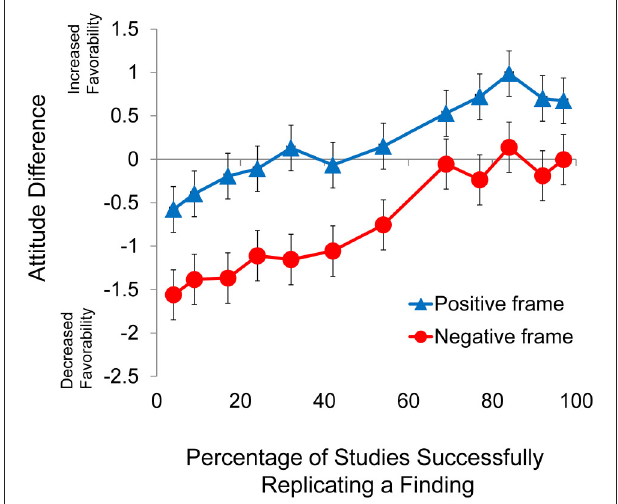
FIGURE 1 | Difference score as a function of frame for Experiments 1a and 1b. Error bars indicate 95% confidence intervals.